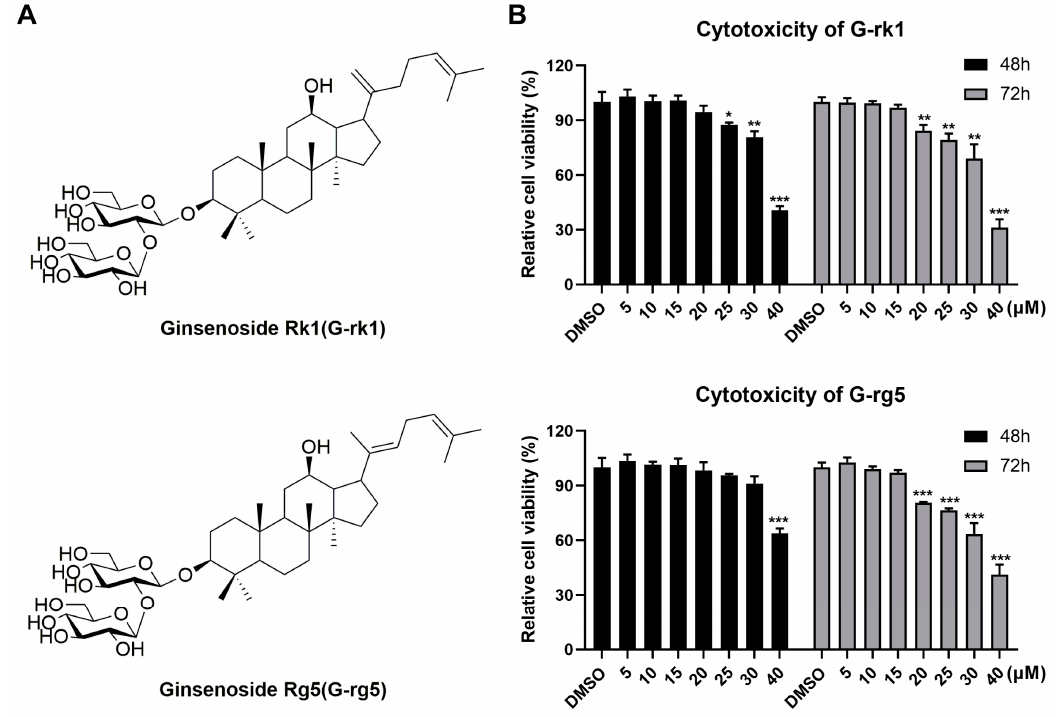
Figure 1. The cellular toxicities of ginsenoside rk1 (G-rk1) and rg5 (G-rg5) on A549 cells. ( A ) The chemical composition of G-rk1 and G-rg5. ( B ) G-rk1 or G-rg5 were applied to confluent A549 cells in varying concentrations. Cell viability was evaluated by the MTT assay at 48 or 72 h. Results are presented as a percentage (%) of cells that received a mock treatment (0.4% DMSO). Values are average (%) ± standard deviation (SD) of three separate assessments. * p < 0.05, ** p < 0.01, and *** p < 0.001 compared to the DMSO control.